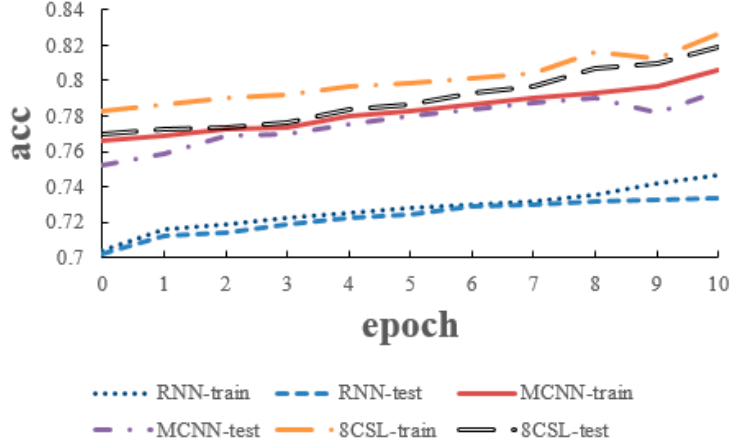
Figure 14. Loss curves of the three models on the 20 second data.